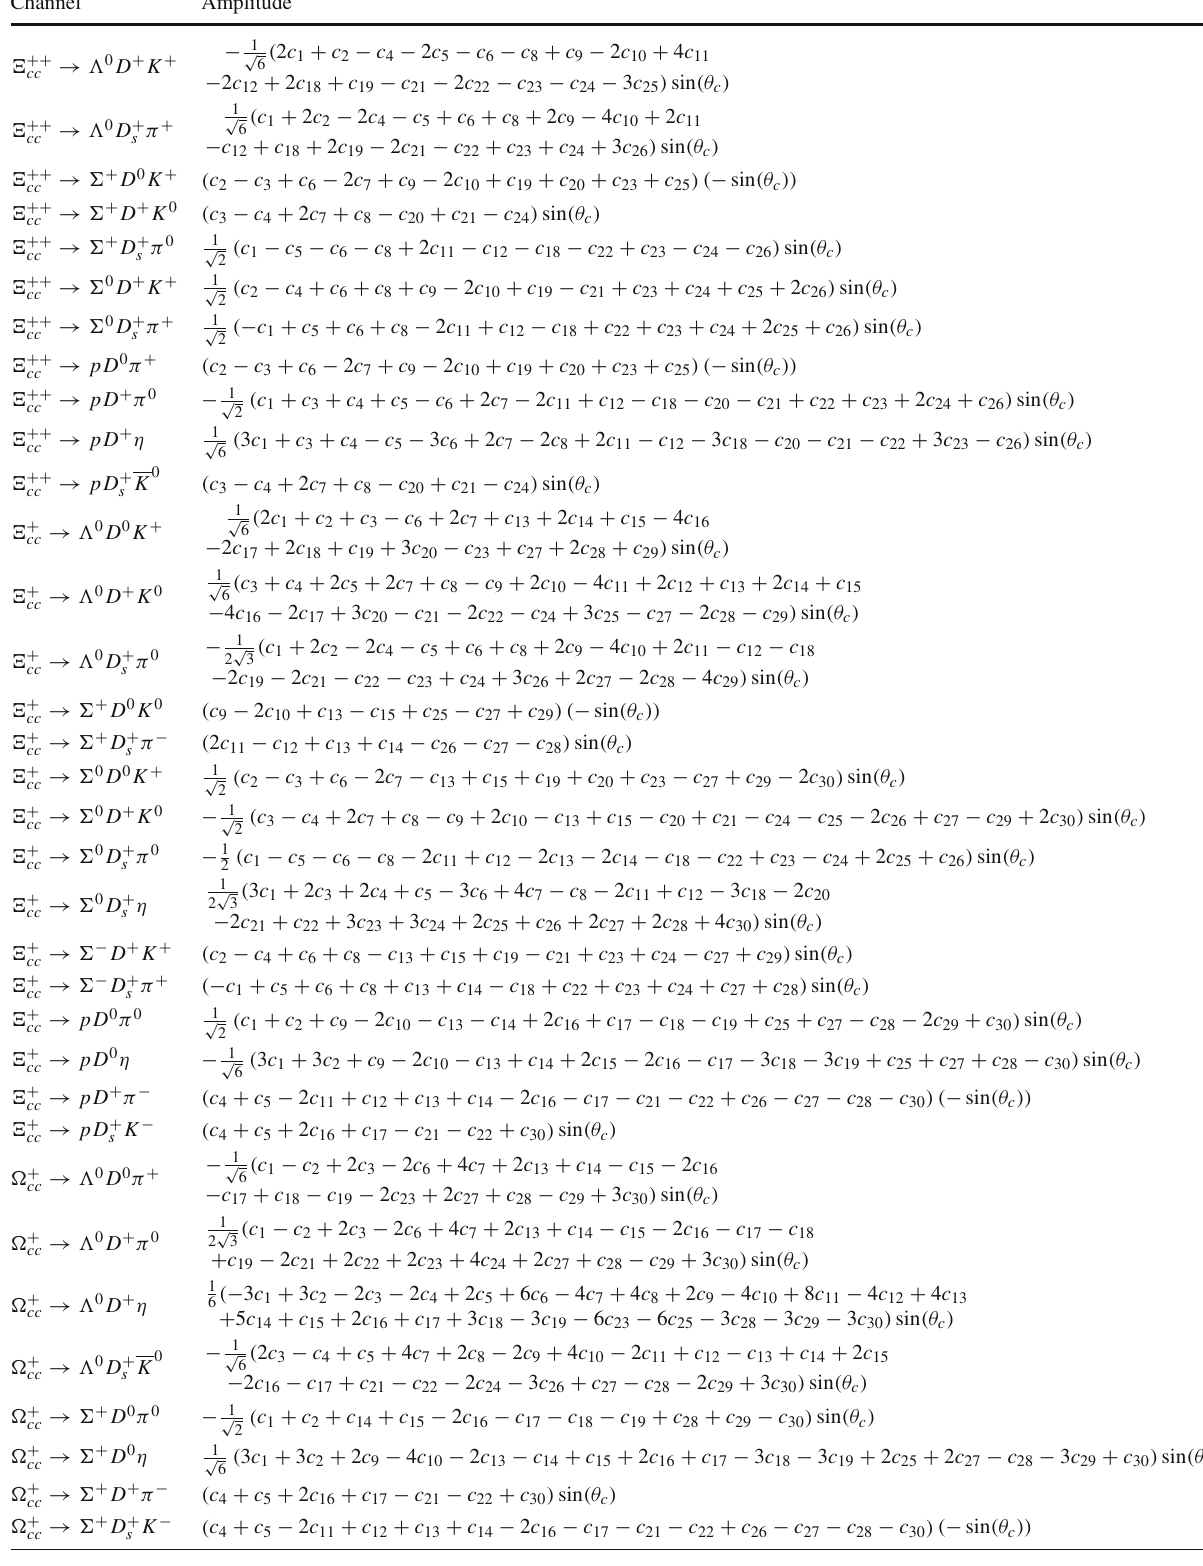
Table 12 Doubly charmed baryon decays into a light baryon in the octet, a charmed meson and a light meson Channel